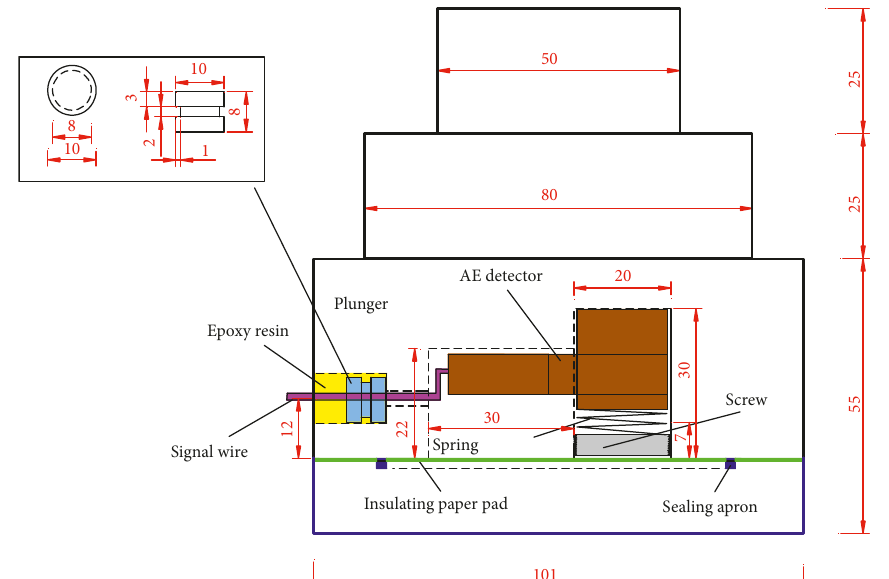
Figure 14: Test head combination renderings.